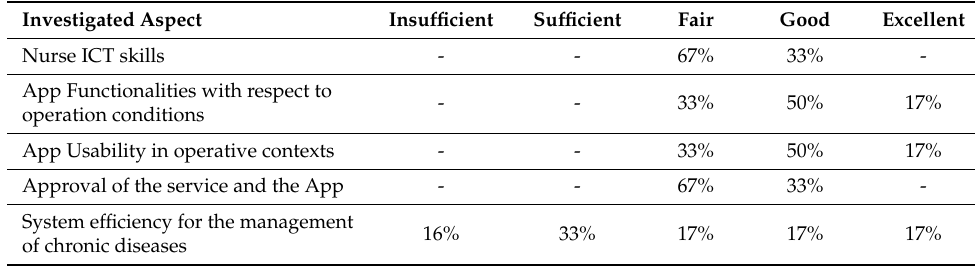
Table 1. Quality of Experience